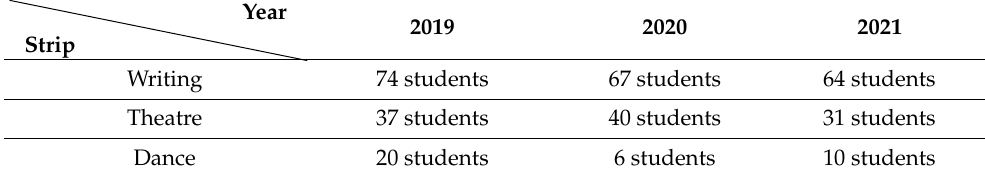
Table 1. Number of Creative Arts Students Based on Specialisation/Strip from 2019 to 2021.